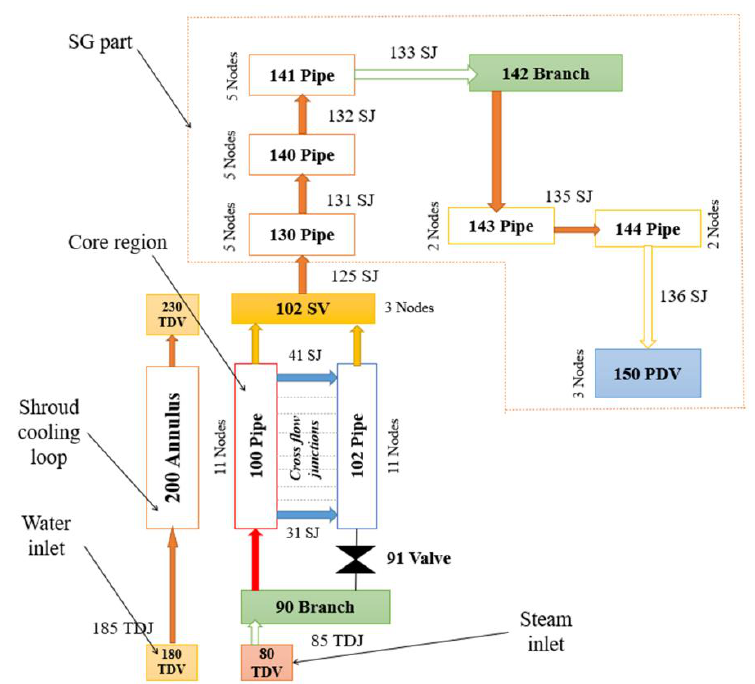
Figure 4. Schematic view of axial nodalization of RELAP model for PHEBUS facility.